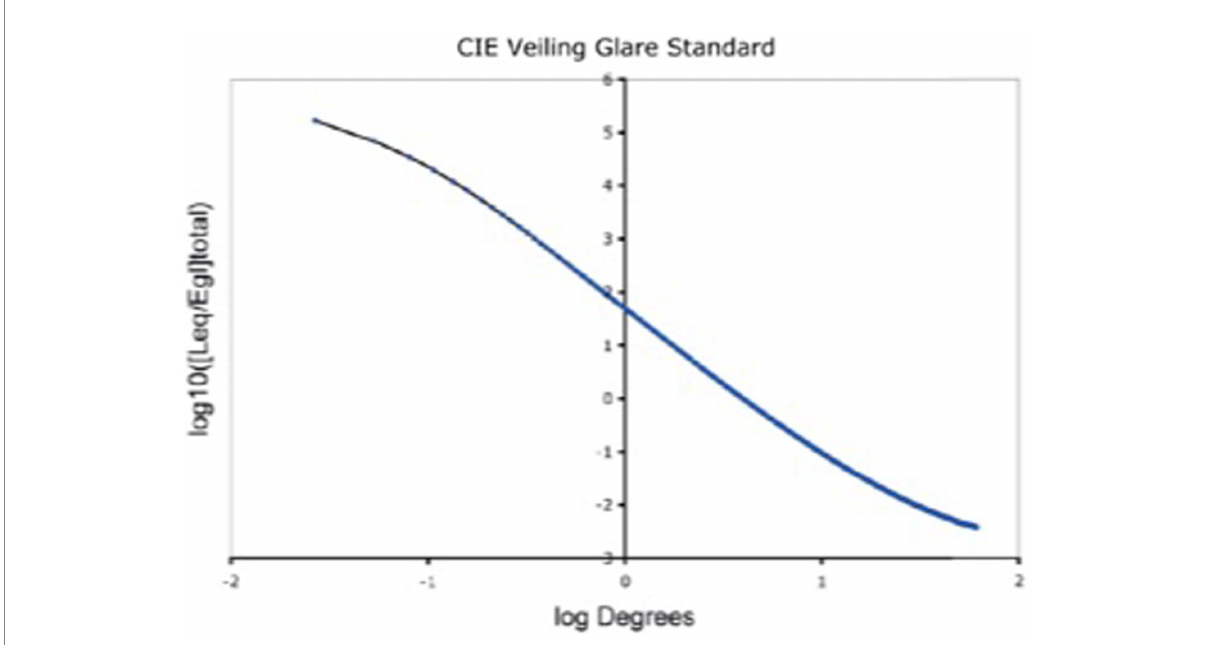
FIGURE 2 Glare Spread Function plotted on log–log axes. Note the extreme ranges of these axes. The horizontal visual-angle axis covers (1 min to 60 ° ). The vertical axis plots the decrease in glare as the function of the angular separation between donor pixel and receiving pixels. It covers 8 log 10 units (150,000 to 0.005). Despite its range, it does not approach a constant asymptote. The glare on each receiving pixel is the unique sum of contribution of all the other scene pixels. Glare is a scene-content-dependent transformation of scene